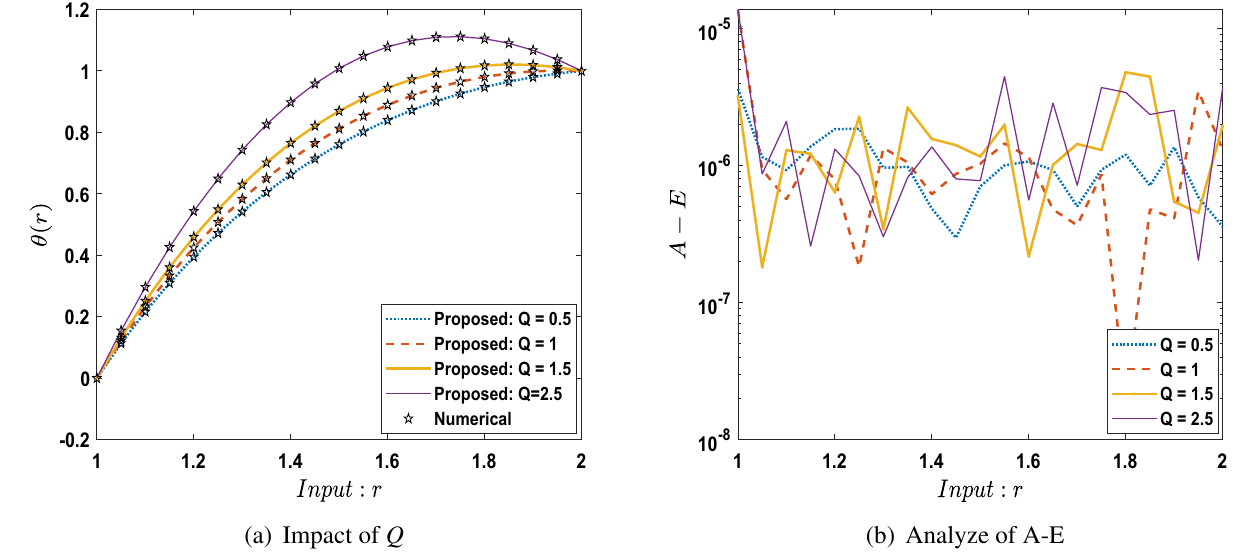
Figure 30. Comparison between suggested LMA-TNN with results of numerical reference for scenario 2 in Reynolds model.